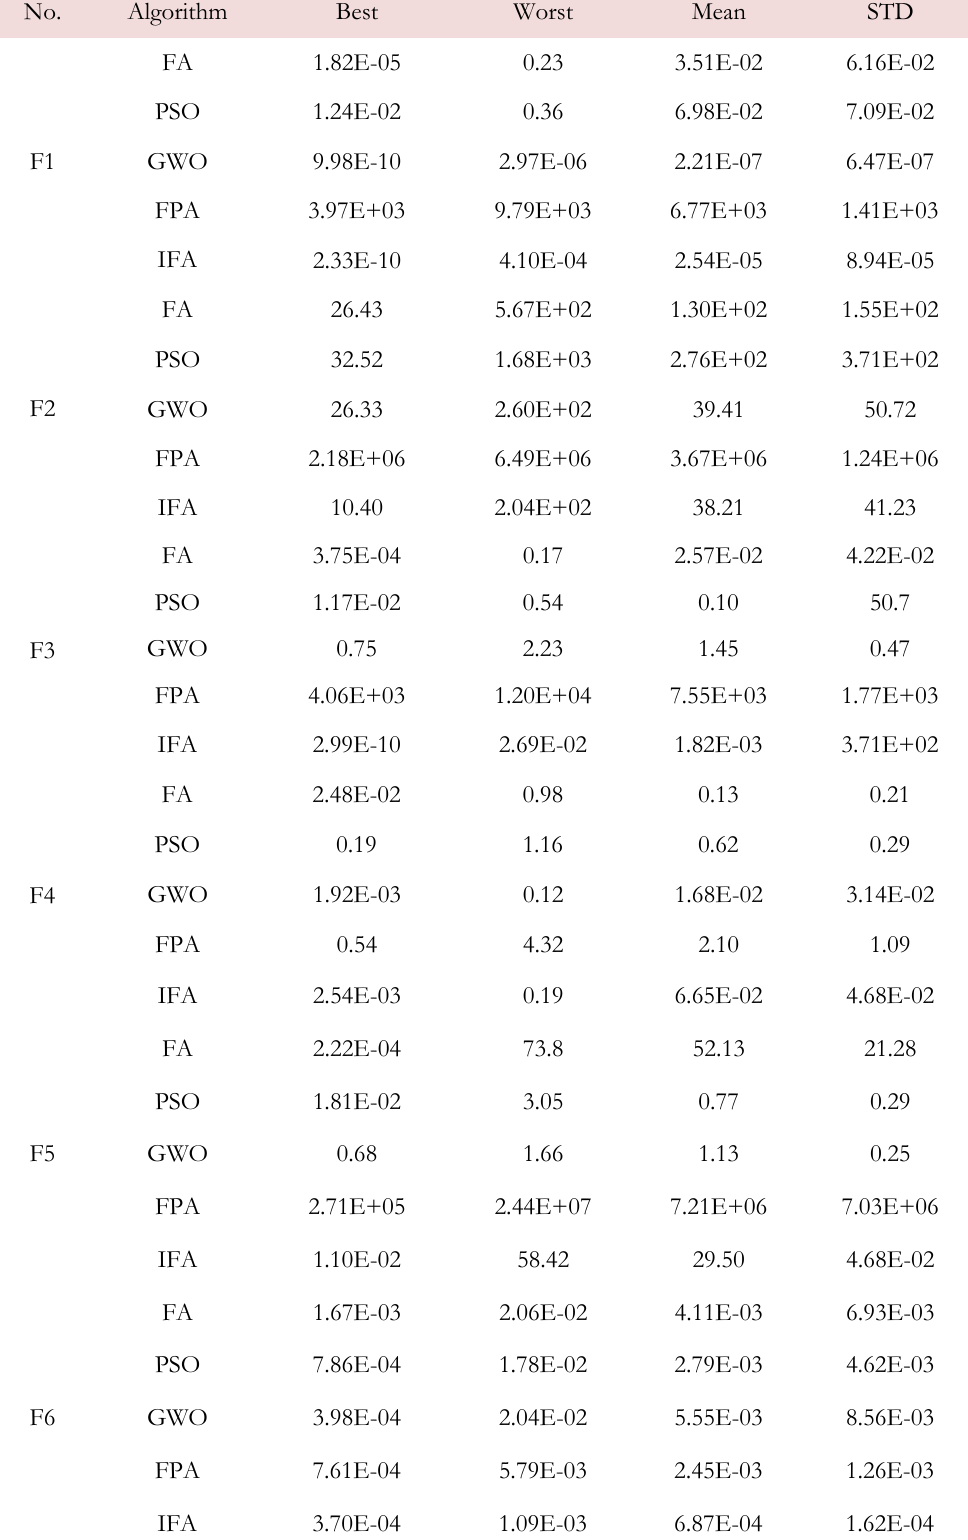
Table 2: Comparison of calculation